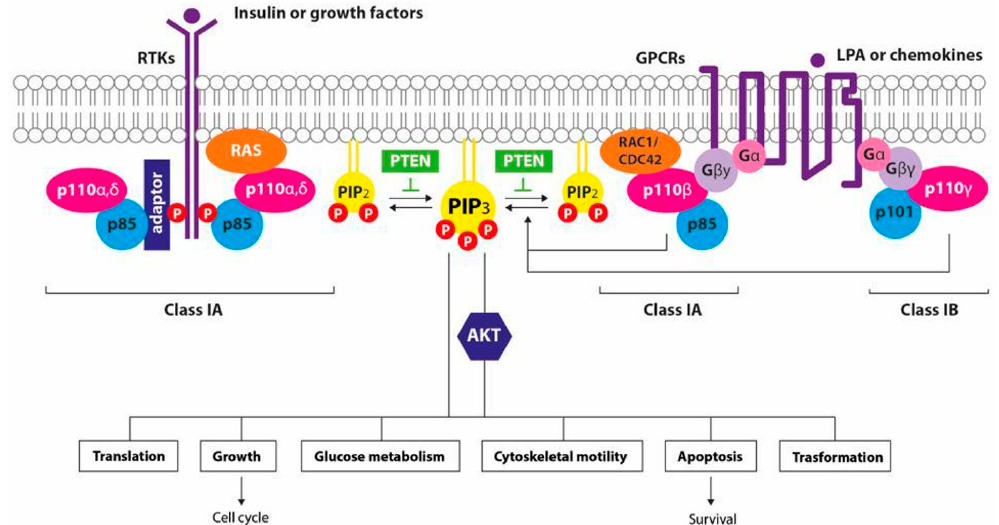
Figure 1. Signaling by PI3K isoforms in summary: growth factors bind their receptors on cell surface and activate the receptor tyrosine kinase (TK) or the G-protein coupled receptor (GPCR), promoting the recruitment of class I PI3Ks. The phosphorylation of PIP2 into PIP3 stimulates the downstream activation of both AKT-dependent and -independent signaling pathways. PTEN acts as regulator, removing the 3 ′ phosphate from PIP3 inactivating the signal perpetuated by class I PI3K [9]. PIK3CA is the main genomic aberration found in hormone receptor positive (HR+) BC, the mutation occurs in the encoding region of the p110 α catalytic subunit of PI3K [4].